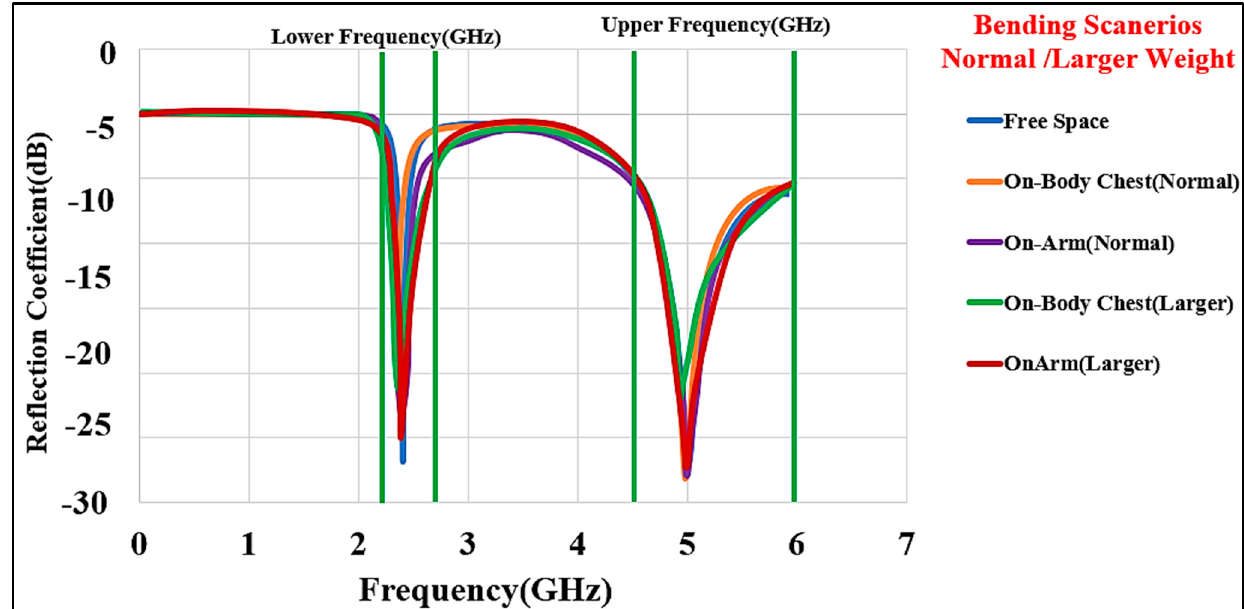
Figure 17. Simulated S 11 for different bending cases. Chest, normal size 100 × 100 × 50 mm 3 , and large size 200 × 200 × 50 mm 3 ; arm, small size 50 mm diameter, length ( l ), 100 mm, and large size 100 mm diameter, length ( l ), 150 mm.